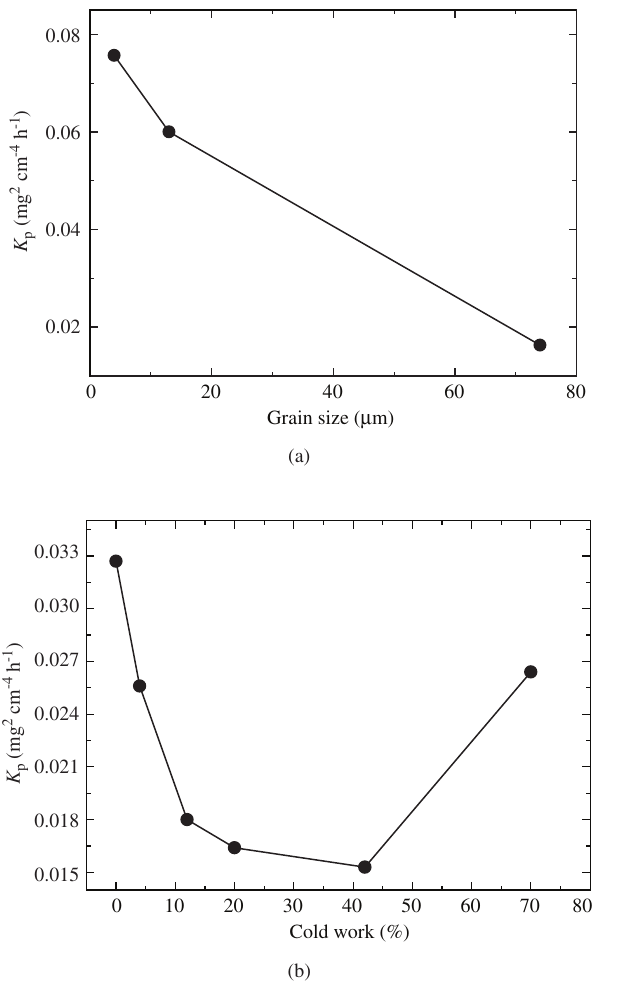
Figure 6. a) Mass change as a function of time for two grain sizes of pure iron at 550 °C for 72 hours; b) cross-section of the scale formed on the surface of pure iron at 550 °C for 72